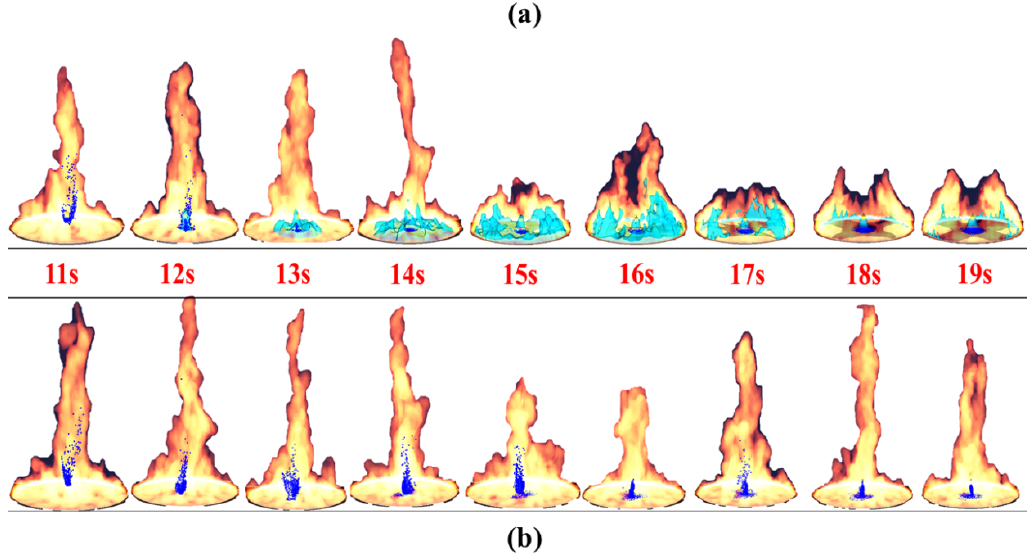
Figure 14. Movement of droplets with fire. ( a ) Mixture, ( b ) water.